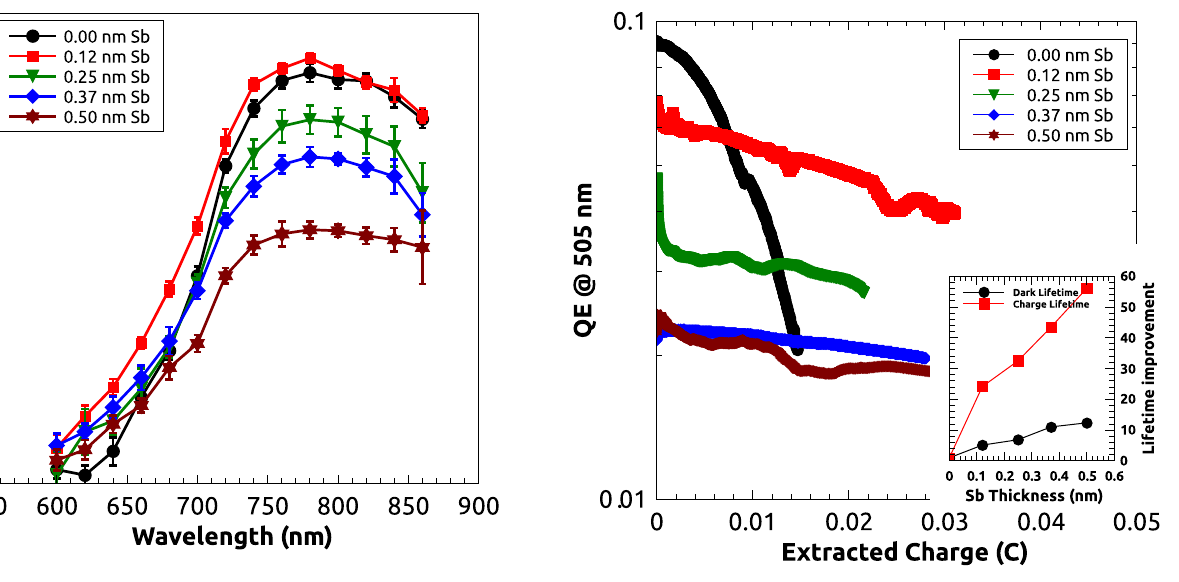
FIG. 6. QE as a function of the extracted charge as measured for the different samples at 505 nm. The data shows that as the thickness of the activating layer is increased, the initial QE value decreases but the lifetime is increased. The inset shows a plot of the lifetime improvement achieved with respect to the Cs-O activated sample for dark lifetime ( τ DL ) and charge lifetime ( τ Q